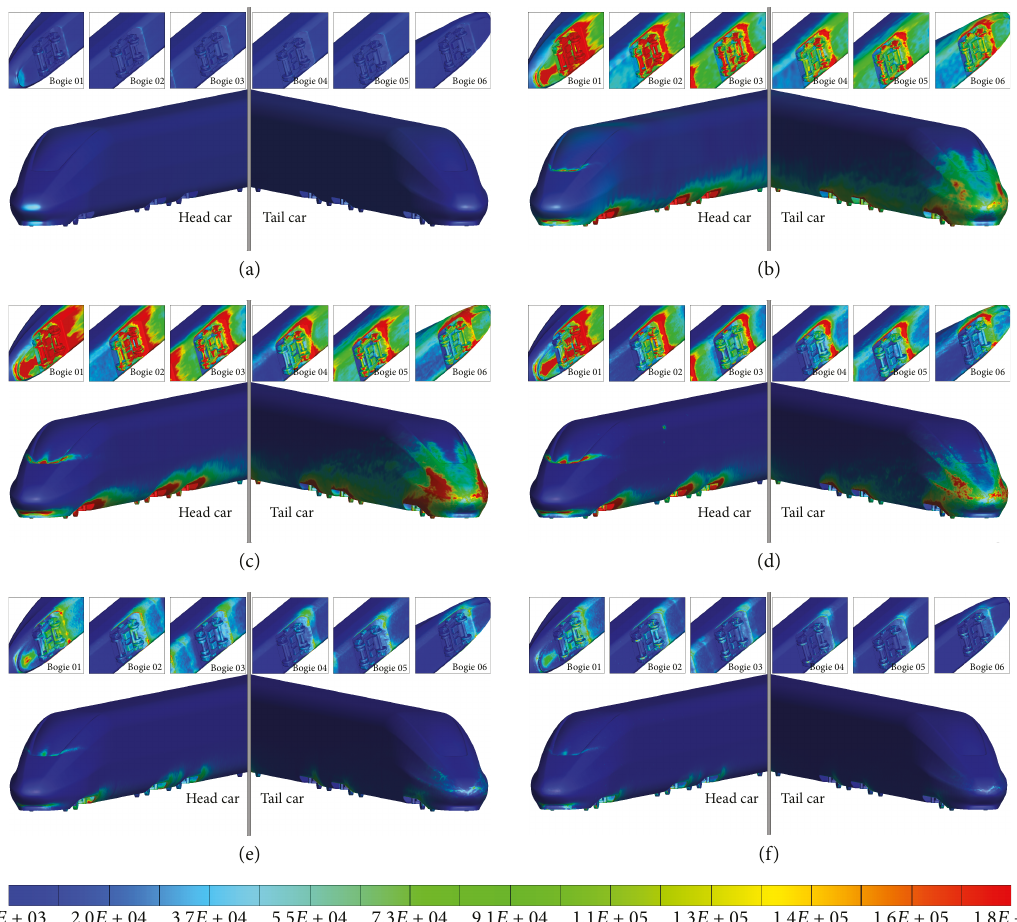
Figure 14: Contour of P ′ on the high-speed train (units: Pa/s; free fl ow speed: 83 m/s): (a) 16Hz, (b) 400Hz, (c) 800 Hz, (d) 2 kHz, (e) 6.3kHz, and (f) 10 kHz.